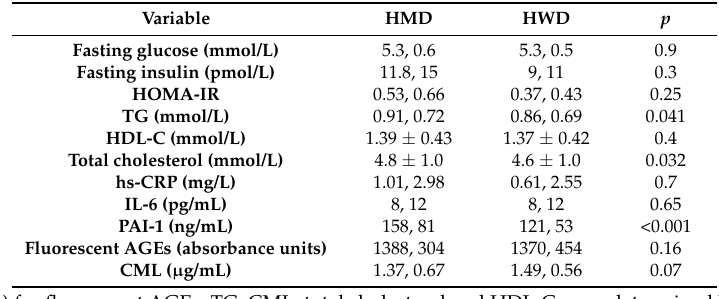
Table 2. Insulin sensitivity, lipids, inflammatory and fibrinolytic markers, and AGEs measured at the end of each dietary period in all participants ( n =